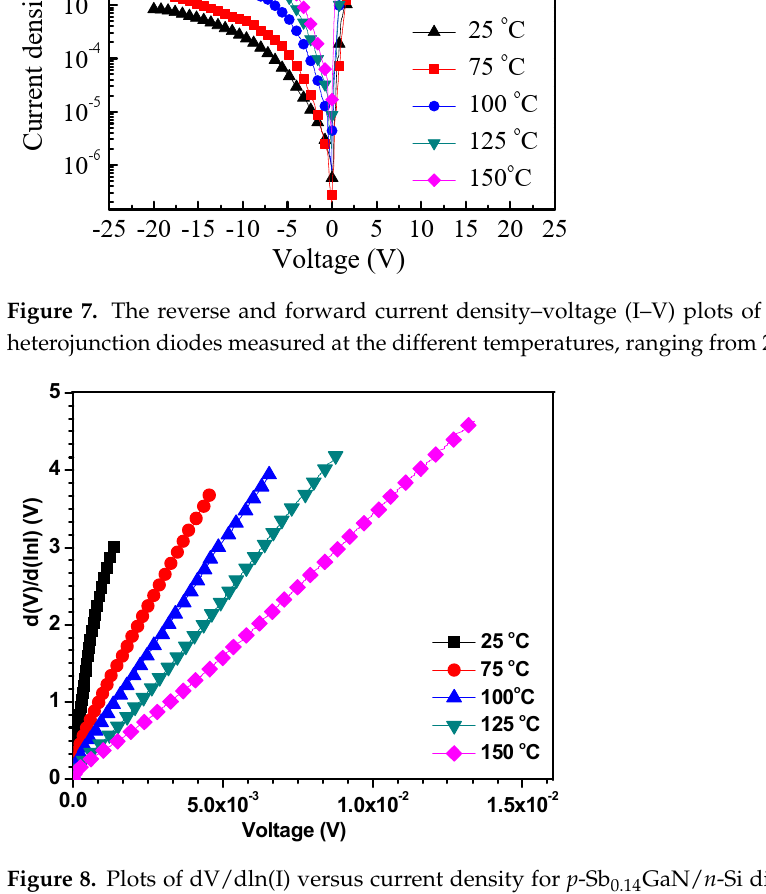
Figure 8. Plots of dV/dln(I) versus current density for p -Sb 0.14 GaN/ n -Si diodes measured at the different temperature.